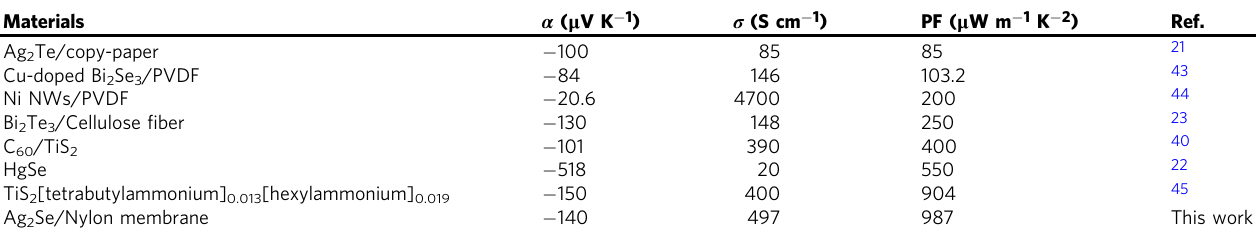
Table 1 Comparison of TE performance of fl exible n-type TE materials at room temperature Materials